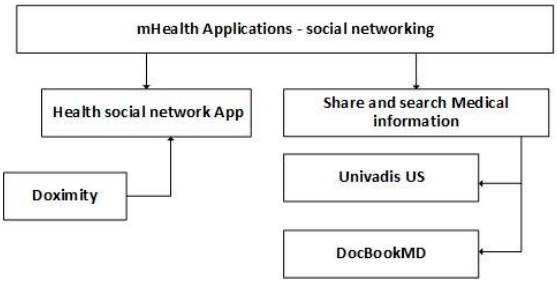
Figure 2. Classification of mobile health applications related to social networking.